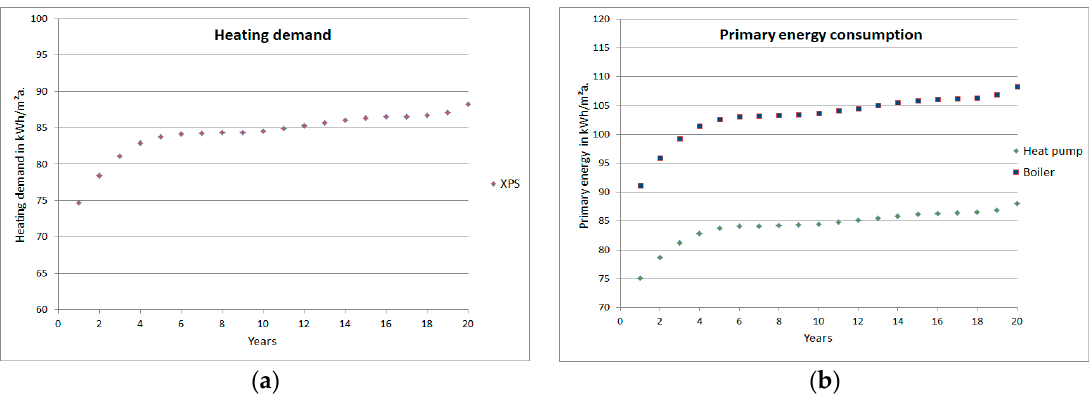
Figure 2. Impact of extruded polystyrene (XPS) insulation degradation on ( a ) heating demand; ( b ) primary energy.